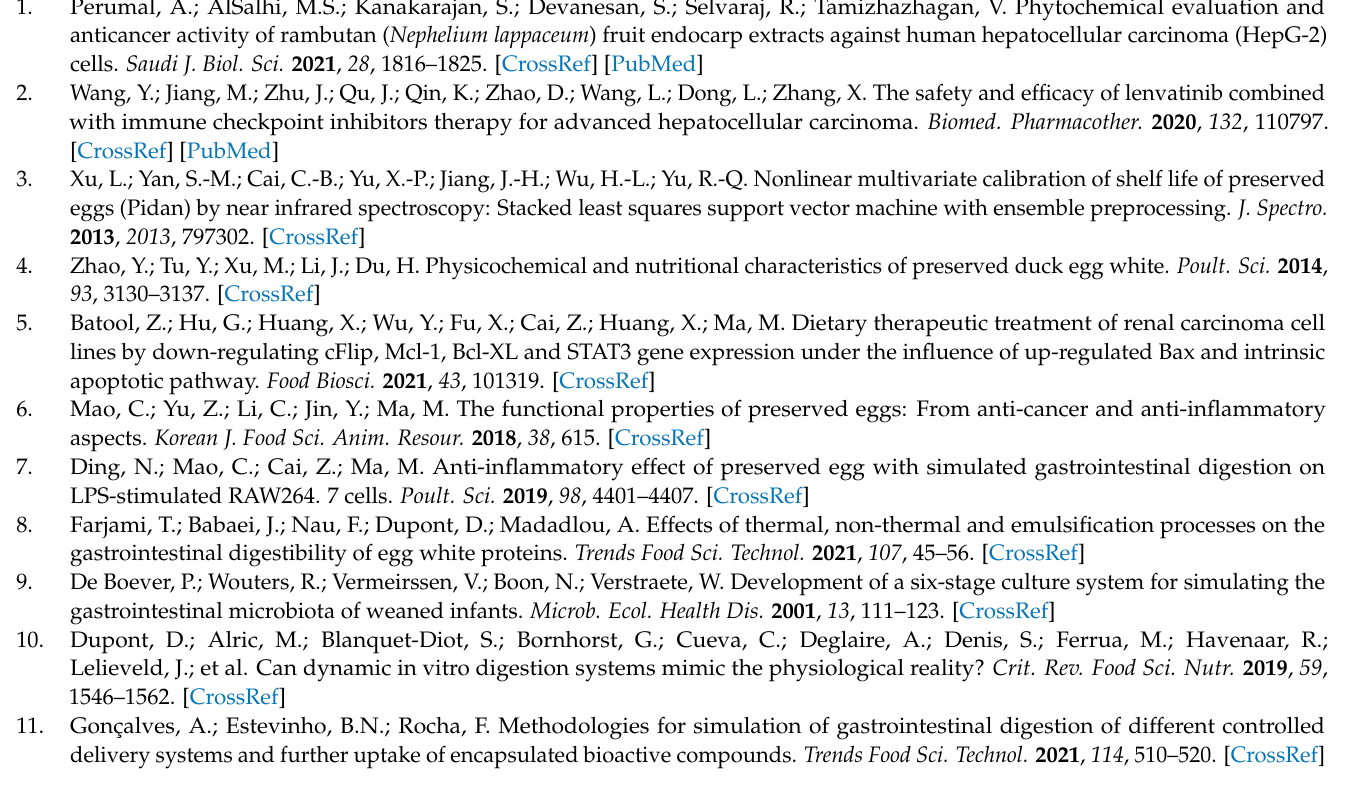
Table S2: The operating parameters of the DHGI-IV system, Table S3: Sequence of primers in RT- qPCR, Table S4: Parameters of k, β , t 1/2 and tlag are obtained by fitting the in vitro gastric retention data with the modified Elashoff’s